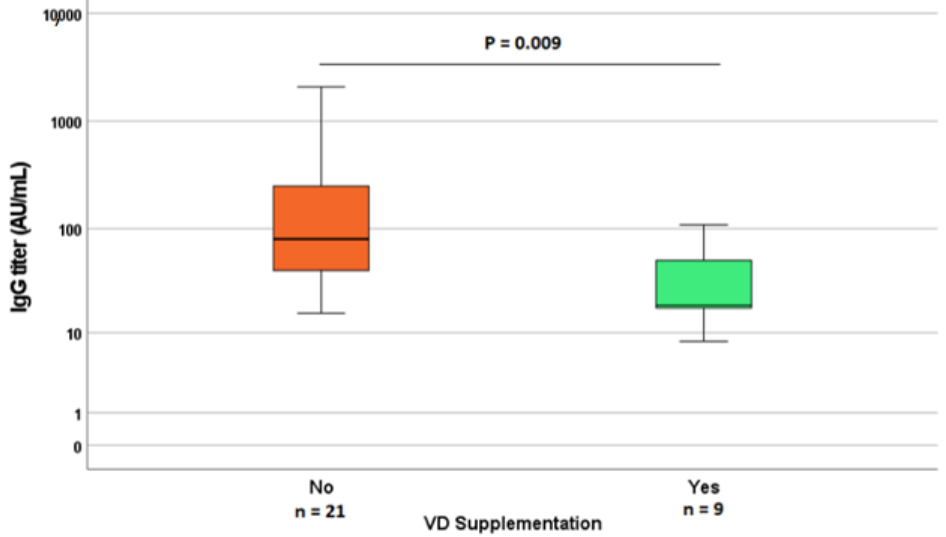
Figure 3. Difference in Anti-SARS-CoV-2 S1/S2 IgG titers between patients taking or not taking VD supplementation.